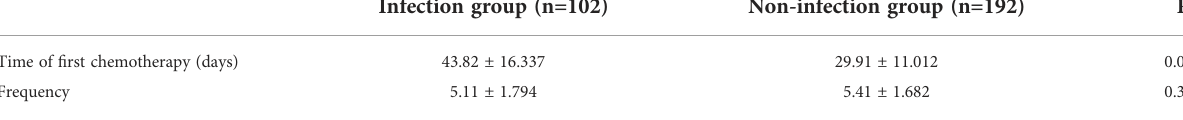
TABLE 3 Time and frequency of postoperative